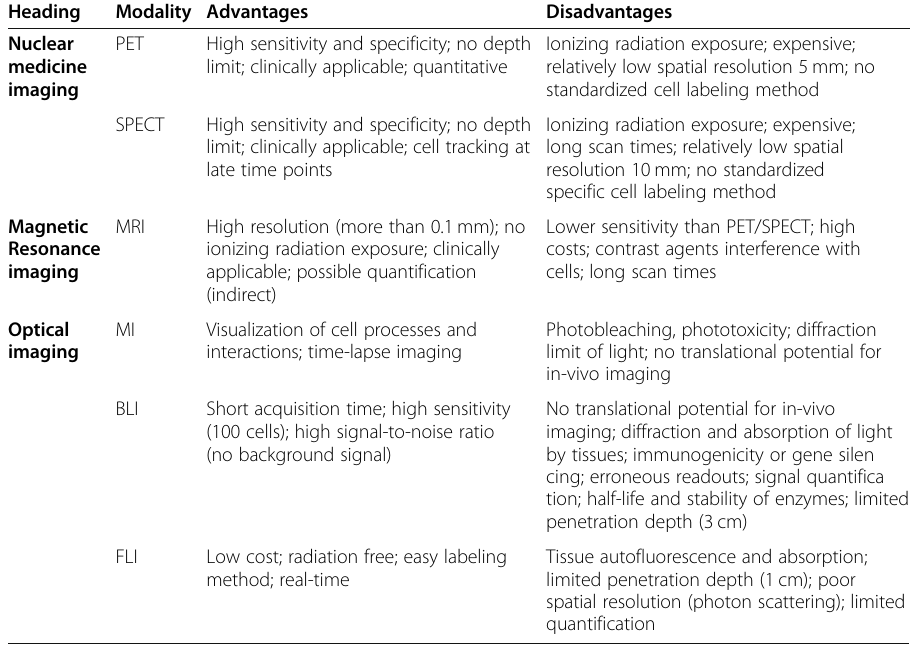
Table 1 Imaging modalities for in vivo tracking of immune cells